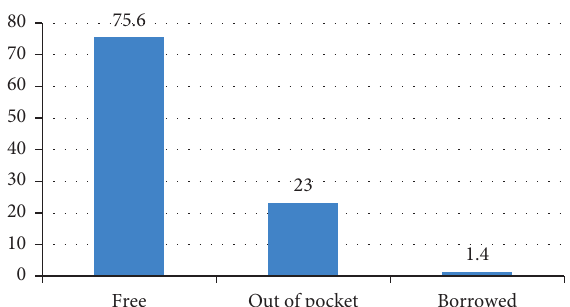
Figure 1: Medical bills of treatment among health professionals in government hospitals, Mekelle City, North Ethiopia,